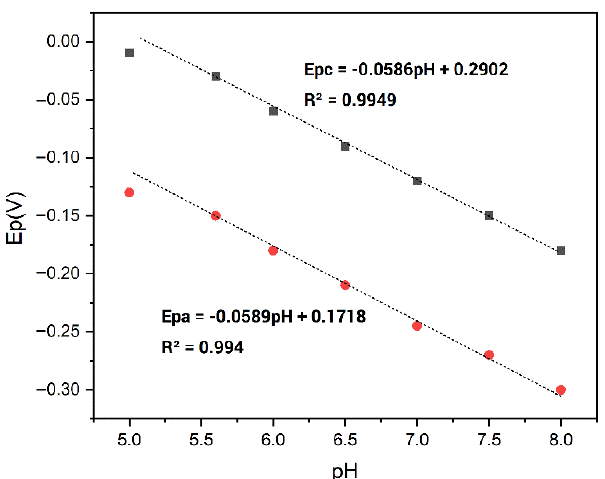
Figure 5. The linear relationship for the formal potentials of SSt- g -PANI@G/Tyase/GCE.